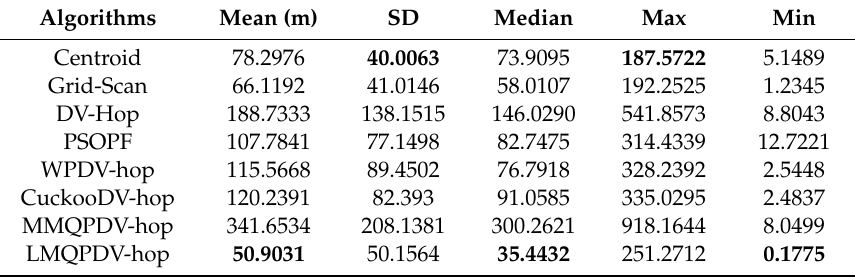
Table 6. Comparison results of location error for WSN#2 through 10 independent